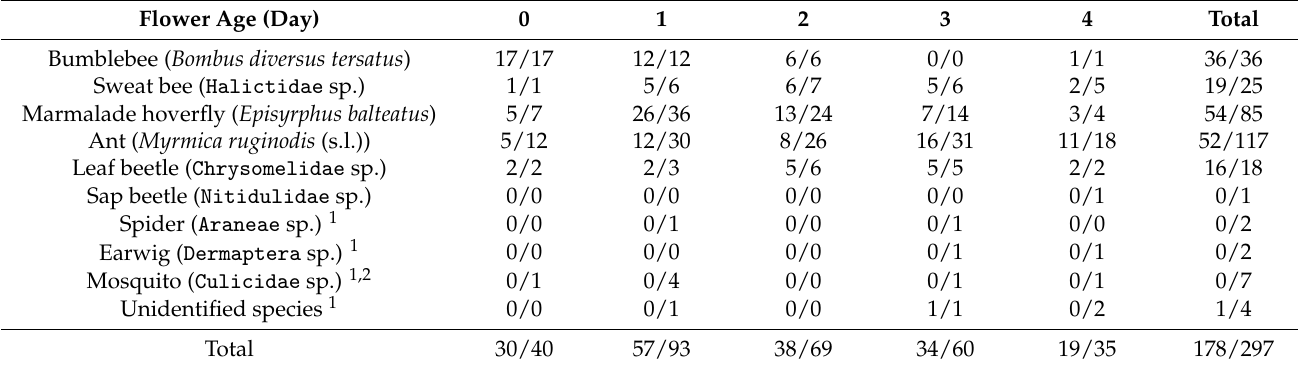
Table 2. The total number of visits of each species in relation to flower age. Flower Age (Day) Bumblebee ( Bombus diversus tersatus ) Sweat bee ( Halictidae sp.) Ant ( Myrmica ruginodis (s.l.)) Leaf beetle ( Chrysomelidae sp.) Sap beetle ( Nitidulidae sp.)